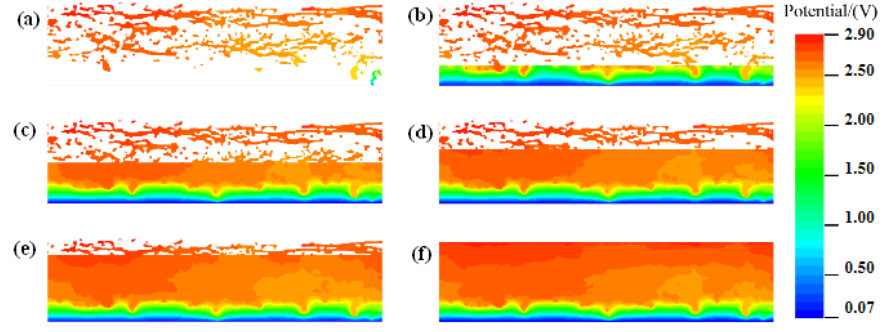
Figure 9. Electric potential distribution: ( a ) 0% filling degree; ( b ) 20% filling degree; ( c ) 40% filling degree; ( d ) 60% filling degree; ( e ) 80% filling degree; ( f ) 100% filling degree.